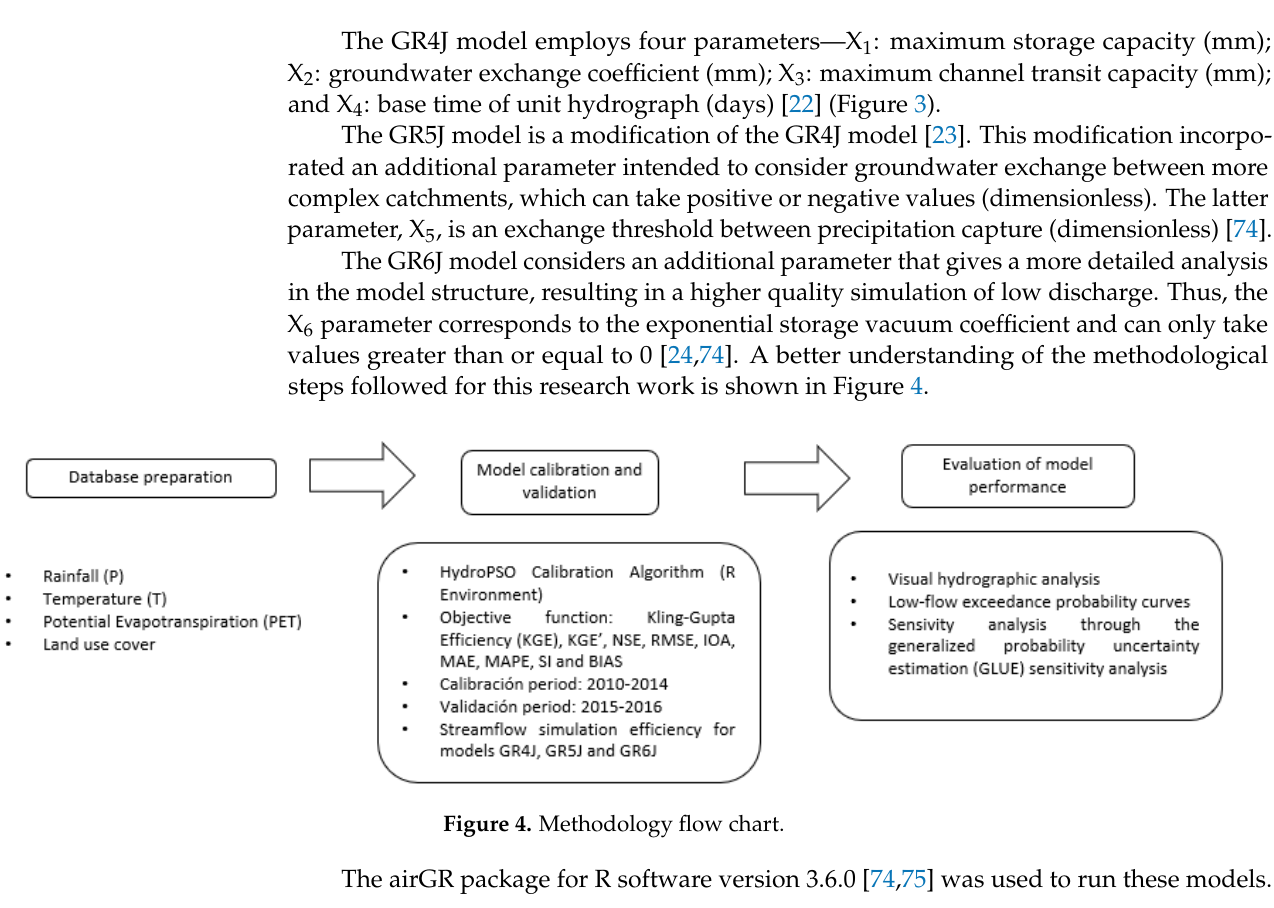
Figure 3. GR4J rainfall–runoff model diagram (modified from [73]).